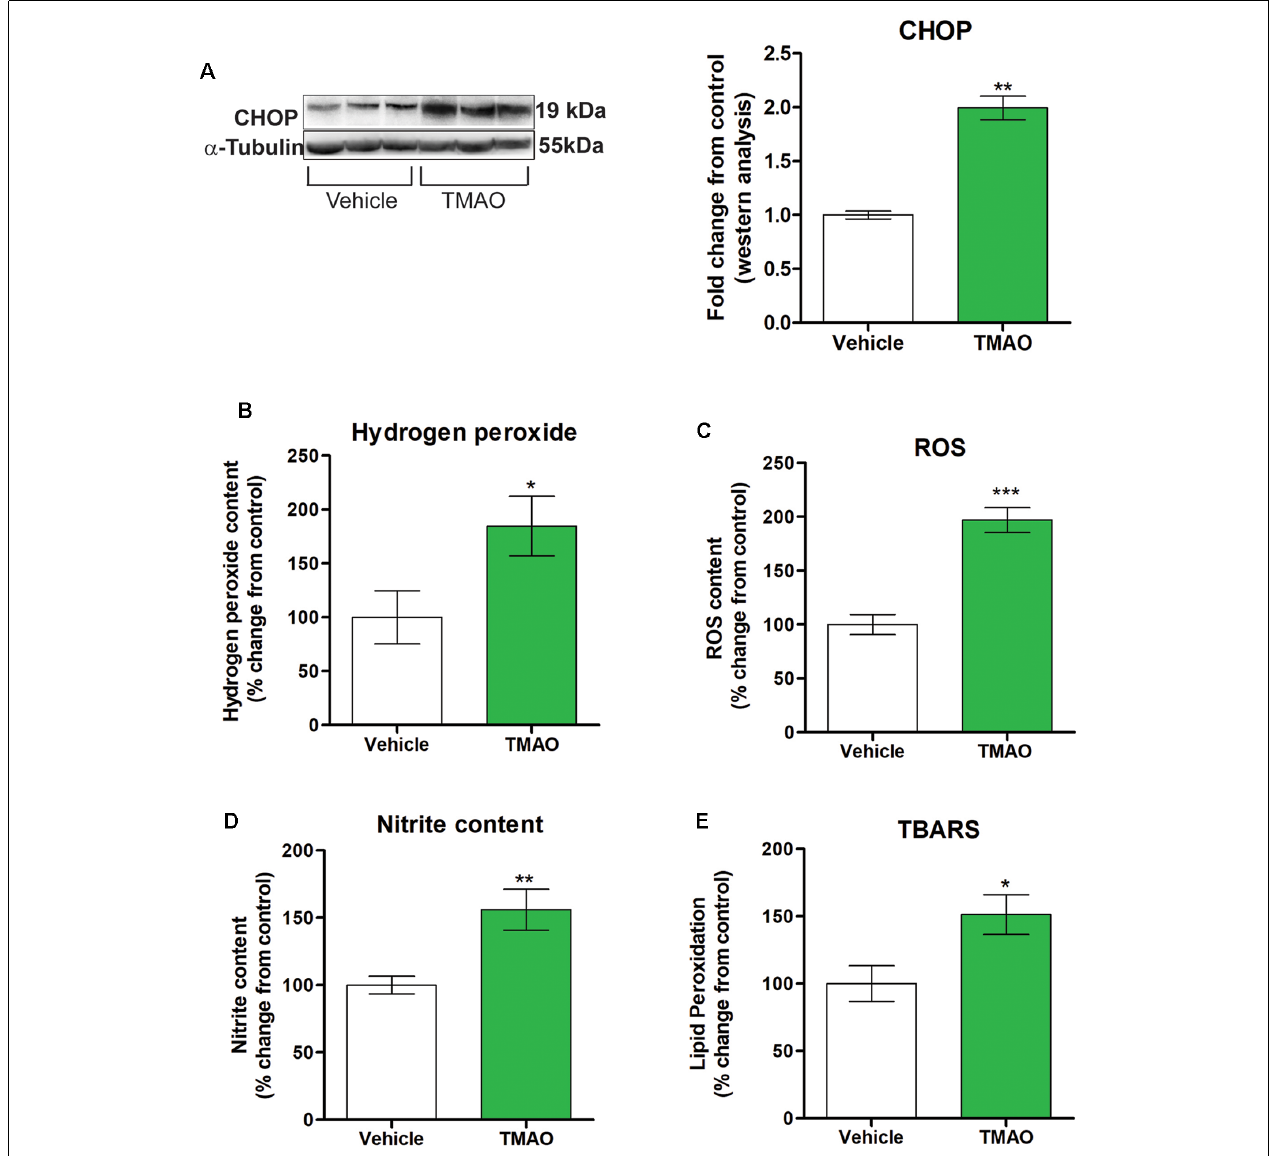
FIGURE 6 | TMAO induces oxidative stress. Hippocampal slices were incubated in ACSF with either 0.03% DMSO (vehicle) or TMAO (50 µ M) for 4 h and the lysates were analyzed for CCAAT-enhance-binding protein homologous protein (CHOP) protein expression and oxidative markers. (A) Representative western blot showing CHOP levels normalized to α -tubulin. (B) Hydrogen peroxide generation in the lysates was measured fluorometrically at Ex/Em 535/587 nm. (C) ROS generation was assayed using DCF dye and measured with a spectrophotometer. (D) Nitrite content was measured using Griess reagent and the azo product formed was measured spectrophotometrically at 545 nm. (E) Lipid peroxidation was estimated by measuring the malondialdehyde (MDA) content in the form of thiobarbituric acid reactive substances (TBARS method) spectrophotometrically. For (A) symbols/bars represent mean ± SEM; *indicates a significant difference between vehicle vs. TMAO treated slices, n = 3 mice per group, * p < 0.05. For (B–E) results are expressed as (%) change as compared to the control, Mean ± SEM; * p < 0.05, ** p < 0.01, *** p <